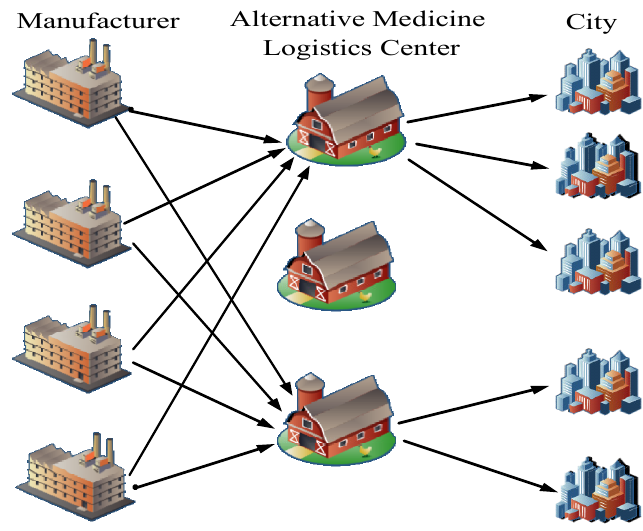
Figure 1. Schematic diagram of medicine logistics network.